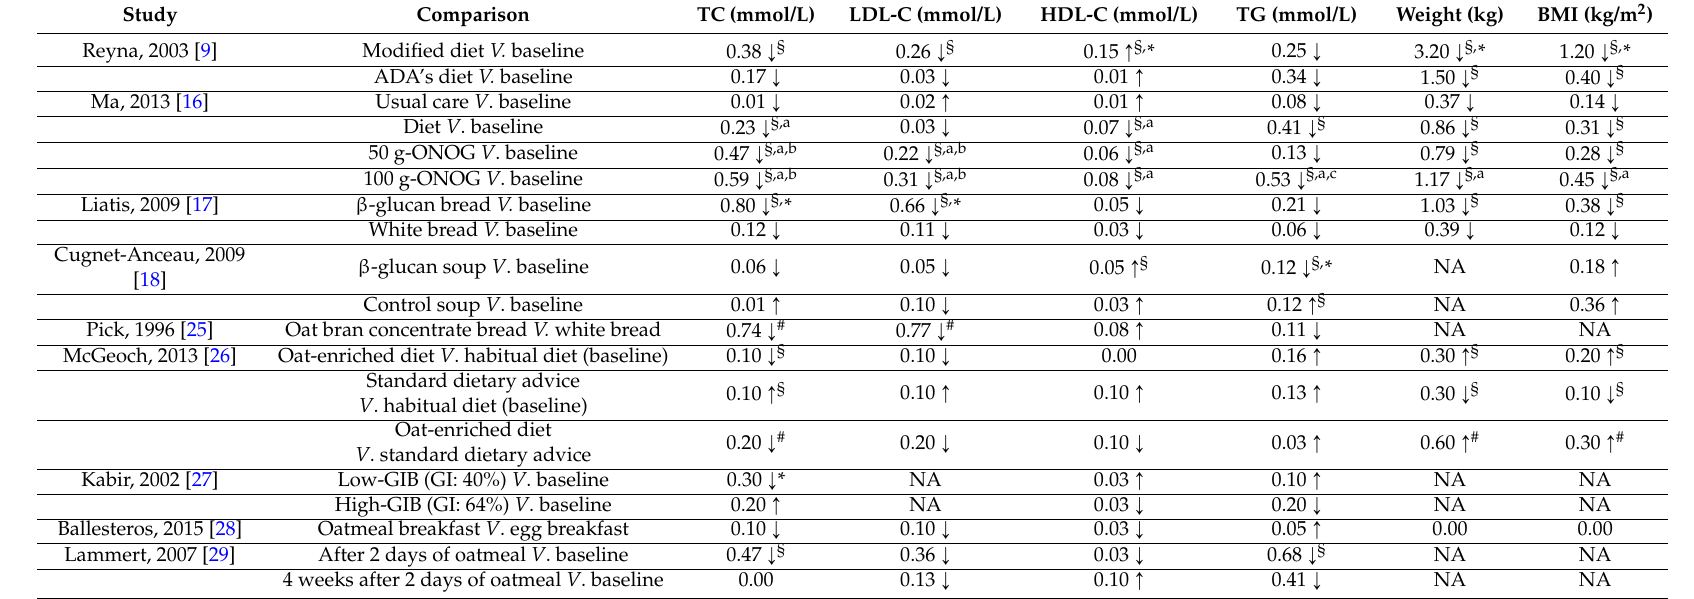
Table 5. Blood lipids and anthropometry parameters after